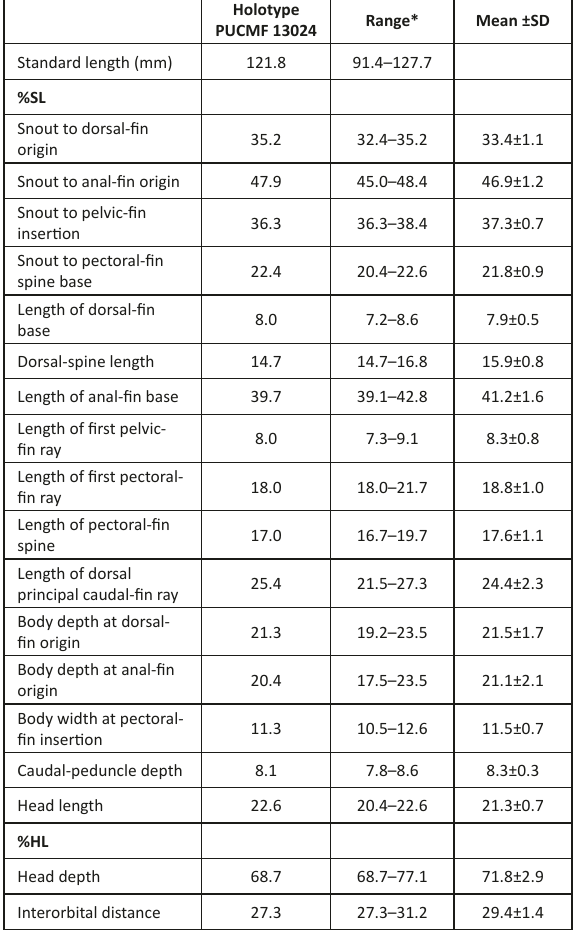
Table 1. Biometric data for Eutropiichthys cetosus sp. nov. (n=6). Holotype Range* Mean PUCMF 13024